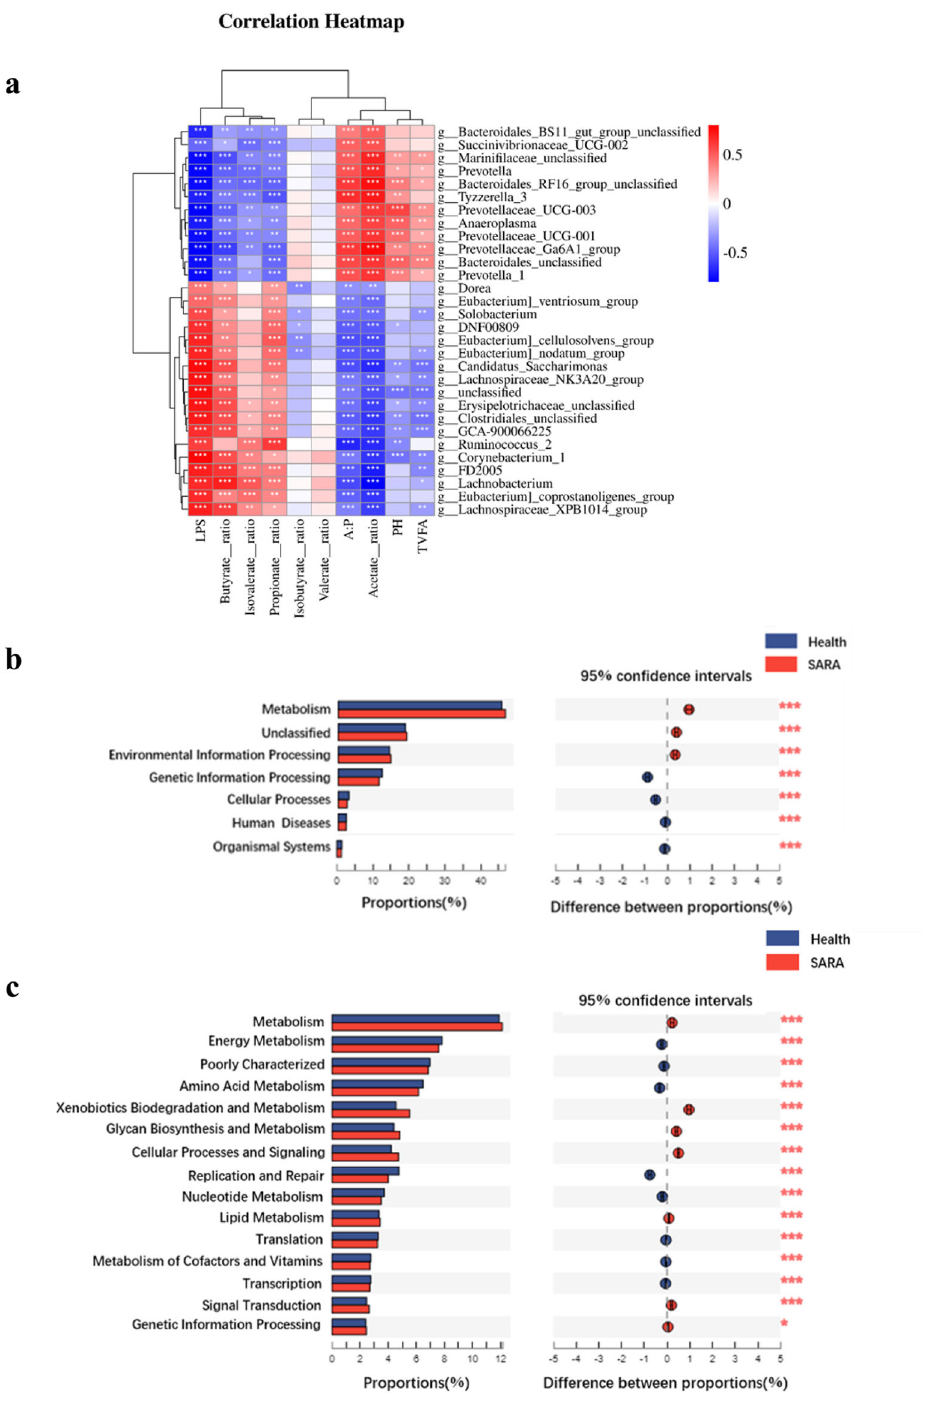
Fig. 4 Correlation analysis and function prediction. a The Pearson correlation between the common genus-level differences in the bacteria during 6 h after feeding in donors from the two groups and their rumen fermentation parameters. b Prediction of the differential function of rumen microbes between two groups of dairy goat donors in multiple KEGG (level 1) categories based on PICRUSt 2. c Prediction of the differential function of rumen microbes between two groups of dairy goat donors in multiple KEGG (level 2) categories based on PICRUSt 2. Health: the dairy goats from the healthy group, SARA: the dairy goats of the SARA group. The Mann-Whitney U test was used with multiple comparisons adjusted by the Benjamini – Hochberg FDR to rank pathways that were signi fi cantly different in predicted metagenome pathways analysis. *Indicates the difference is at a signi fi cant level with p < 0.05, **indicates the difference is at a signi fi cant level with p < The functional composition pro fi les of rumen microorganisms acids. The 17 genera that increased signi fi cantly in the SARA group were predicted from 16 S rRNA sequencing data using PICRUSt2 were signi fi cantly positively correlated with the ruminal LPS (phylogenetic investigation of communities by reconstruction of concentration and the ruminal proportion of propionate, butyrate, unobserved states 2), and as shown in comparison with the and isovalerate (Fig. 4a).